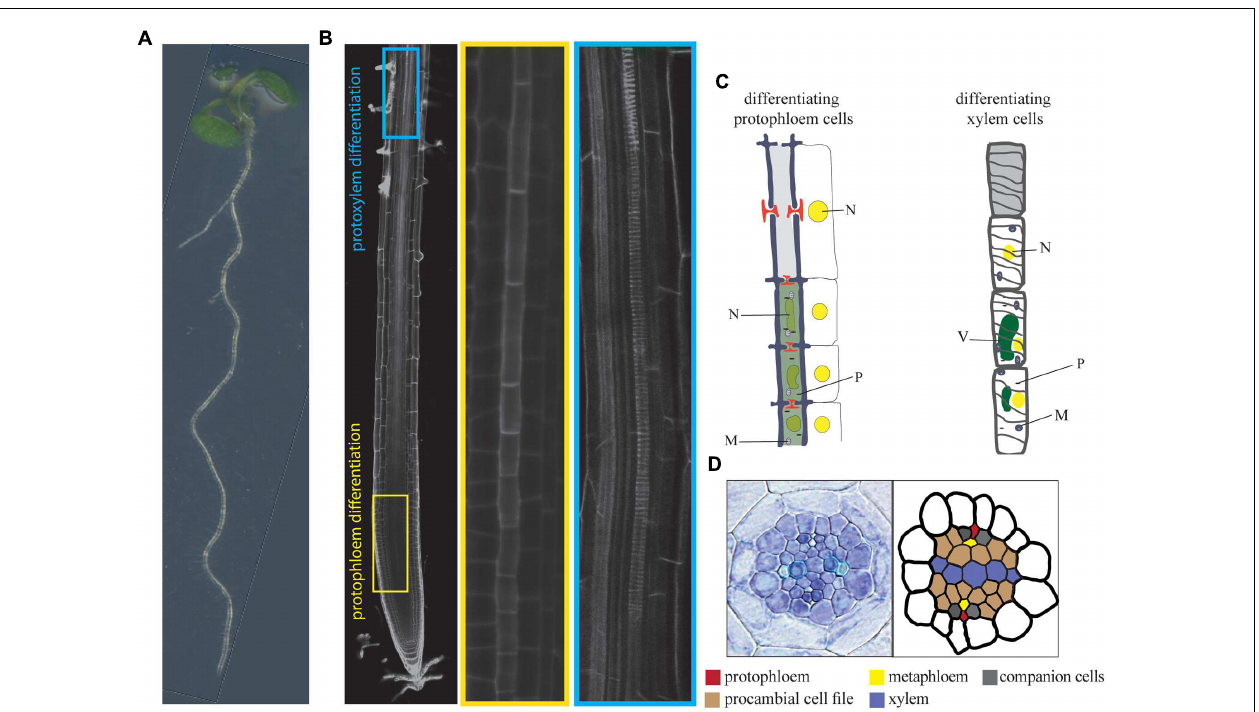
FIGURE 1 | Vascular differentiation in Arabidopisis roots. (A) Arabidopsis thaliana seedling which root tip is shown in detail in (B) . (B) A propidium-iodide stained root tip imaged using confocal microscopy which differentiating protophloem (highlighted in yellow) and protoxylem (highlighted in blue) strands are magnified on the right panels. (C) Schematic representation of subcellular events associated to protophloem and xylem differentiation. (D) Radial organization of root stele. N: Nucleus; P: Plastids; M: Mitochondria; V: